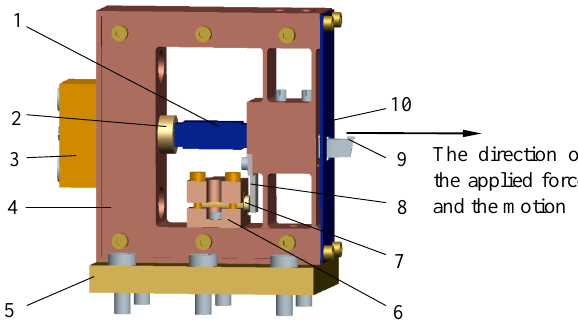
Figure 2: A schematic view of the FTS. The main parts concludes: (1) the piezoelectric actuator, (2) Figure 2. A schematic view of the FTS. The main parts concludes: the preload screw, (3) the lock screw base, (4) the CM structure, (5) the base, (6) the sensor holder, (1) the piezoelectric actuator, (2) the preload screw, (3) the lock (7) the sensor, (8) the sensor plate, (9) the cutting tool, and (10) the front cover. Figure 1. FTS is in the intersection of CM and PE and its design screw base, (4) the CM structure, (5) the base, (6) the sensor holder, Figure 1: FTS is in the intersection of CM and PE and its design requirements are displayed requirements are displayed. Piezoelectric actuator has high resolution, high stiffness and high frequency response. Therefore a (7) the sensor, (8) the sensor plate, (9) the cutting tool, and (10) the An innovative design of FTS is designed to hold various diamond cutting tools and to perform front piezoelectric stacked actuator is used for larger stroke. Three different lengths of the stacked turning operations as shown in Figure 2. It consists of several parts: a CM structure, a piezoelectric actuators which are 18mm (PPA10M), 28mm (PPA20M), and 48mm (PPA40M) from Cedrat Technologies SA can be used in this research project. Different preload screws with corresponding length for each of the piezoelectric stacked actuators are used to house the actuators in the same CM. Spring steel material has been chosen in taking into account of greater Young’s modulus. The CM structure is symmetric and its rigid part can only move in one direction (axial direction), without movement along the other two directions (horizontal and vertical ones). The rigid part can hold various diamond cutting tools. The tool tip should move in the central line of the CM structure. The working frequency of the FTS, , is no more than the natural frequency, , of the CM. is decided by the mass of the rigid part of the CM structure, m s , and the stiffness of the axial stiffness of the CM,